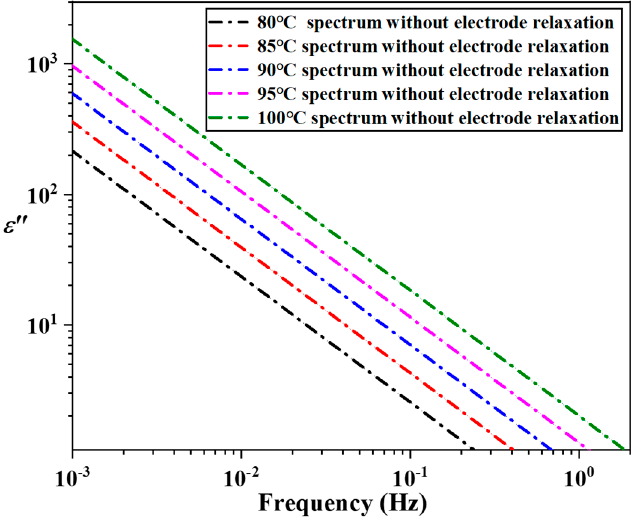
Figure 9. Compound spectra for linear conduction and LFD processes in a high-temperature range.